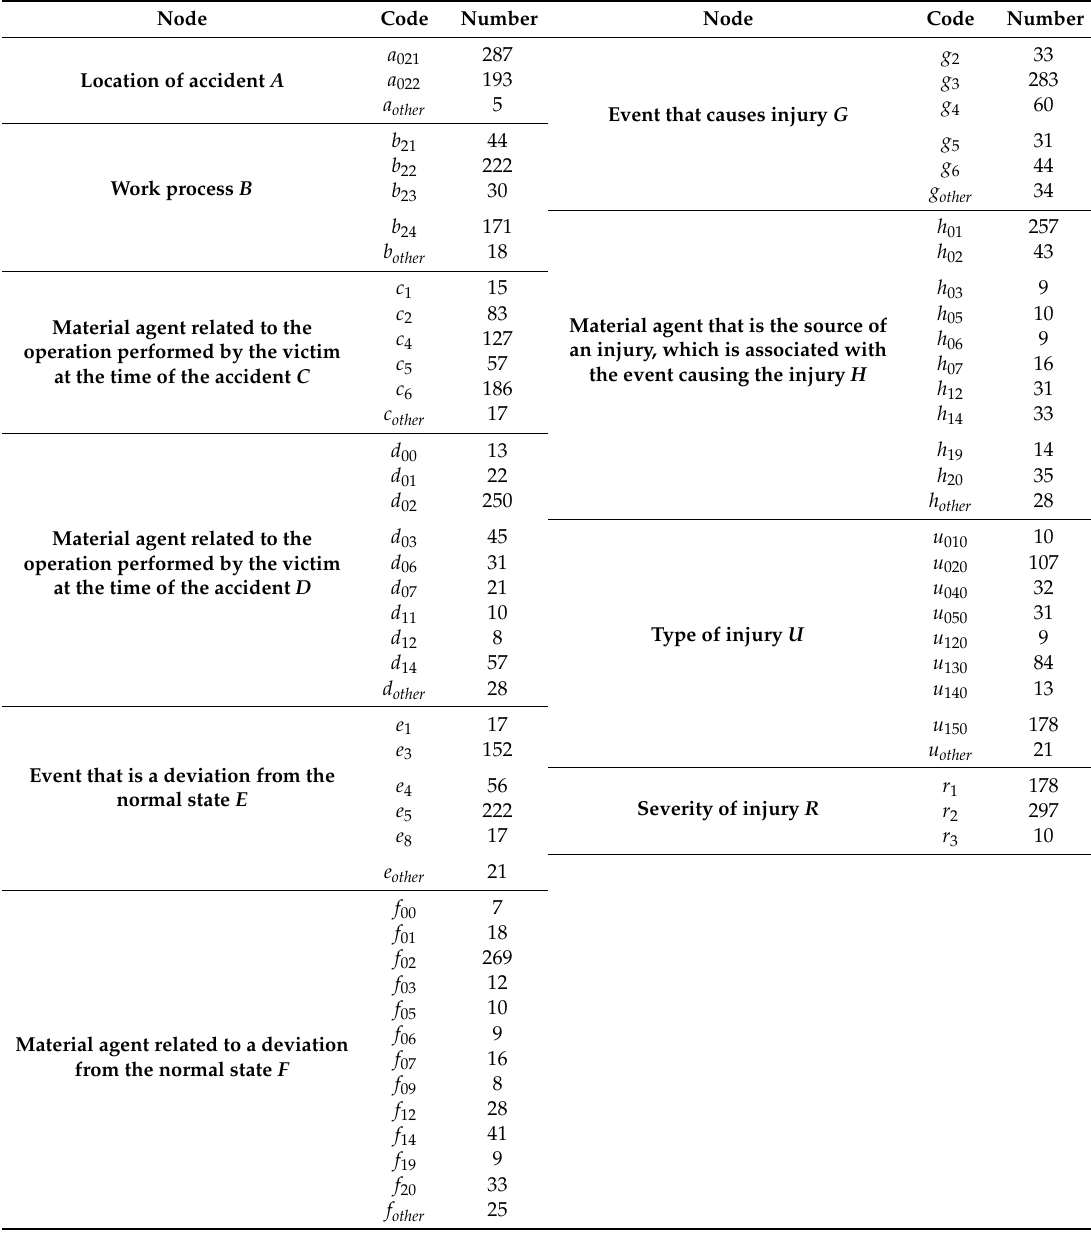
Table 2. Number of activations of individual nodes in the graph.